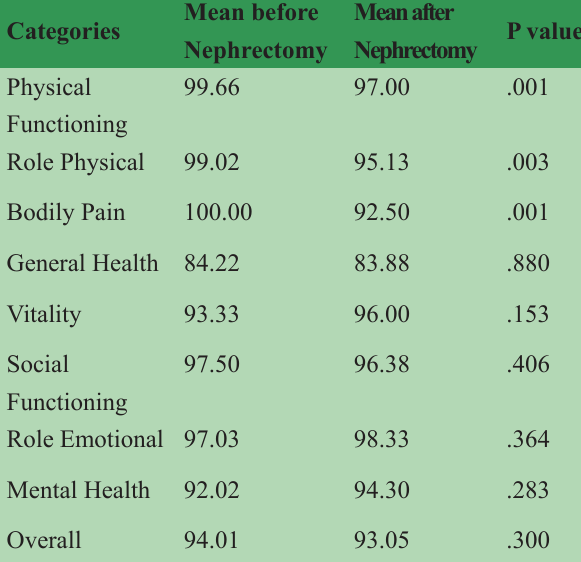
Table 3: Comparison of QOL scores across several categories of SF 36 using paired T-test, before and after donor nephrectomy